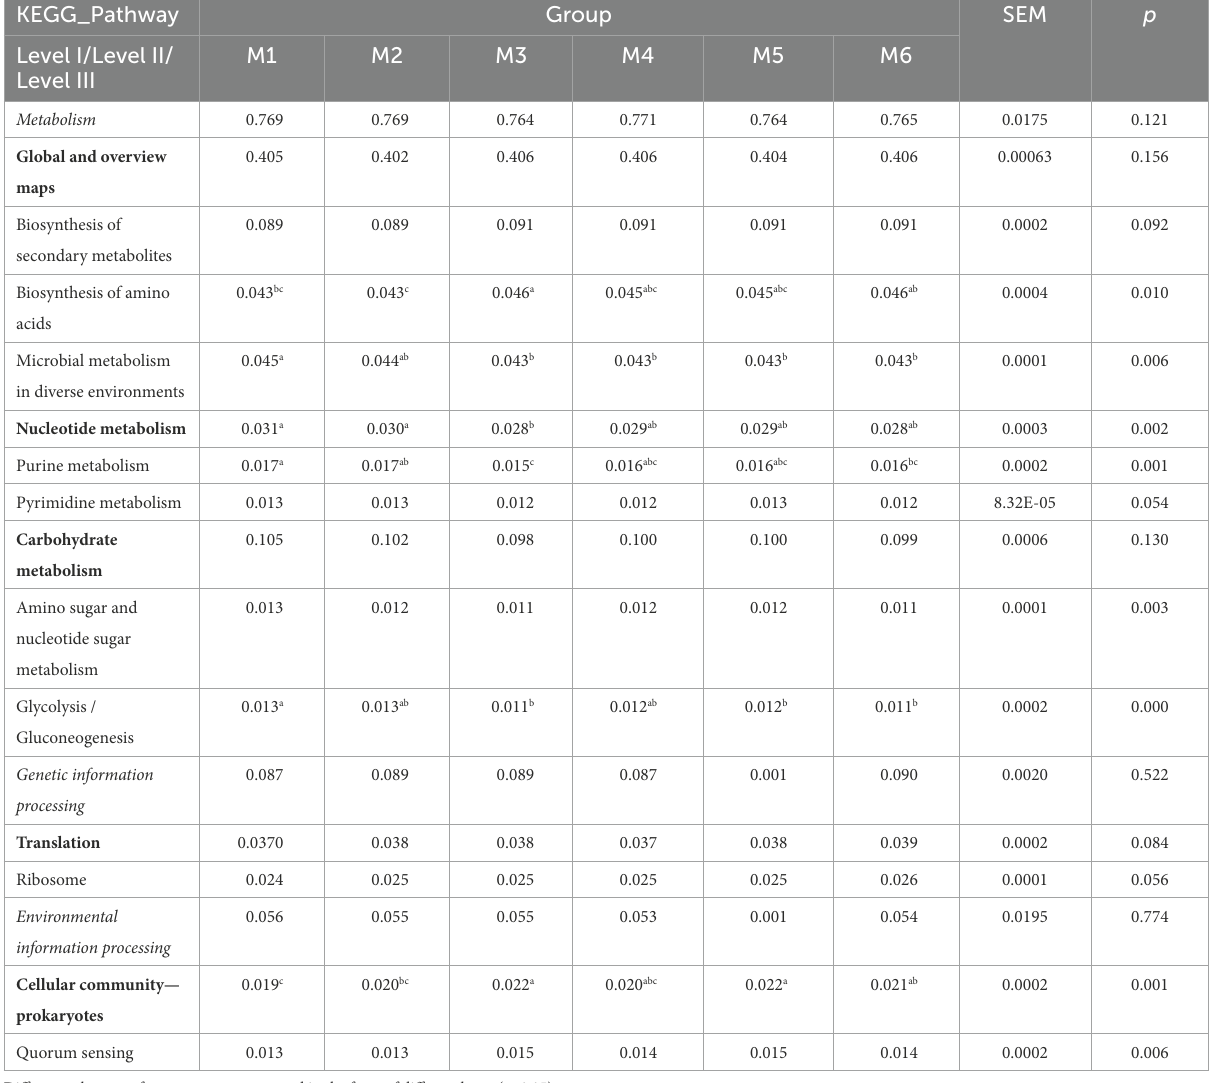
TABLE 1 Functional predictions of significantly different KEGG pathways of fecal bacteria at three levels (only level III pathways that were significantly different at p < 0.05 and abundances >0.01% are shown). KEGG_Pathway